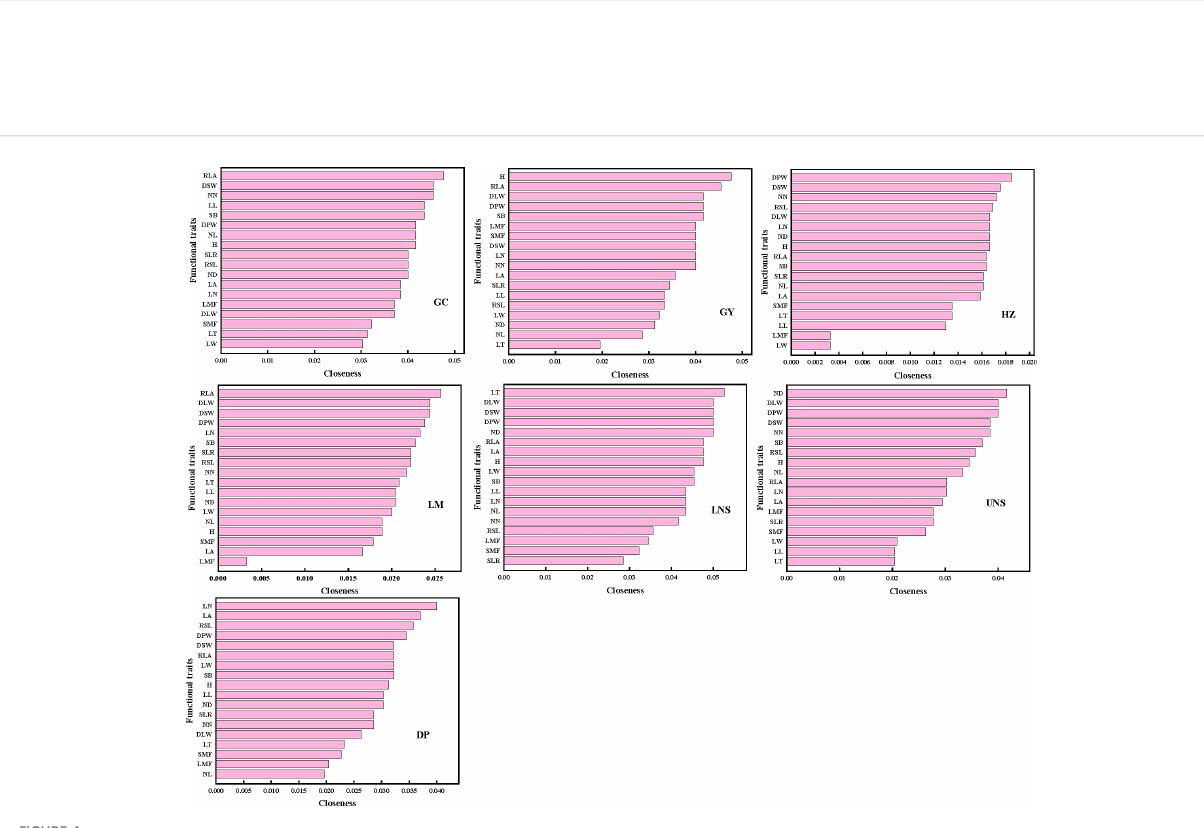
FIGURE 4 The closeness of functional traits in plant trait network of impounded lakes and Grand Canal. GC, GY, HZ, LM, LNS, UNS and DP are abbreviations for Grand Canal, Gaoyou Lake, Hongze Lake, Luoma Lake, lower Nansi Lake, upper Nansi Lake and Dongping Lake,